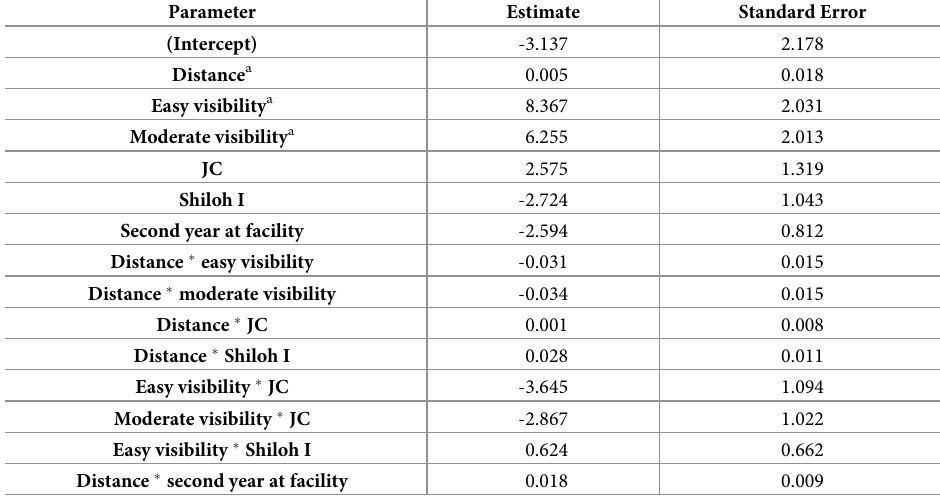
Table 5. Model parameters for logistic regression of searcher efficiency (response was the log-odds of a detection) at the Juniper Canyon (JC), Big Horn I (BH I), Big Horn II (BH II), and Shiloh I wind energy facilities. The refer- ence parameter (i.e., the intercept) predicts detection probability at zero distance in difficult visibility during the first year at the Big Horn I (BH I) and Big Horn II (BH II) wind energy facilities. Note that this reference condition does not occur in the data because difficult visibility areas were not searched at the Big Horn I (BH I) and Big Horn II (BH II) wind energy facilities.